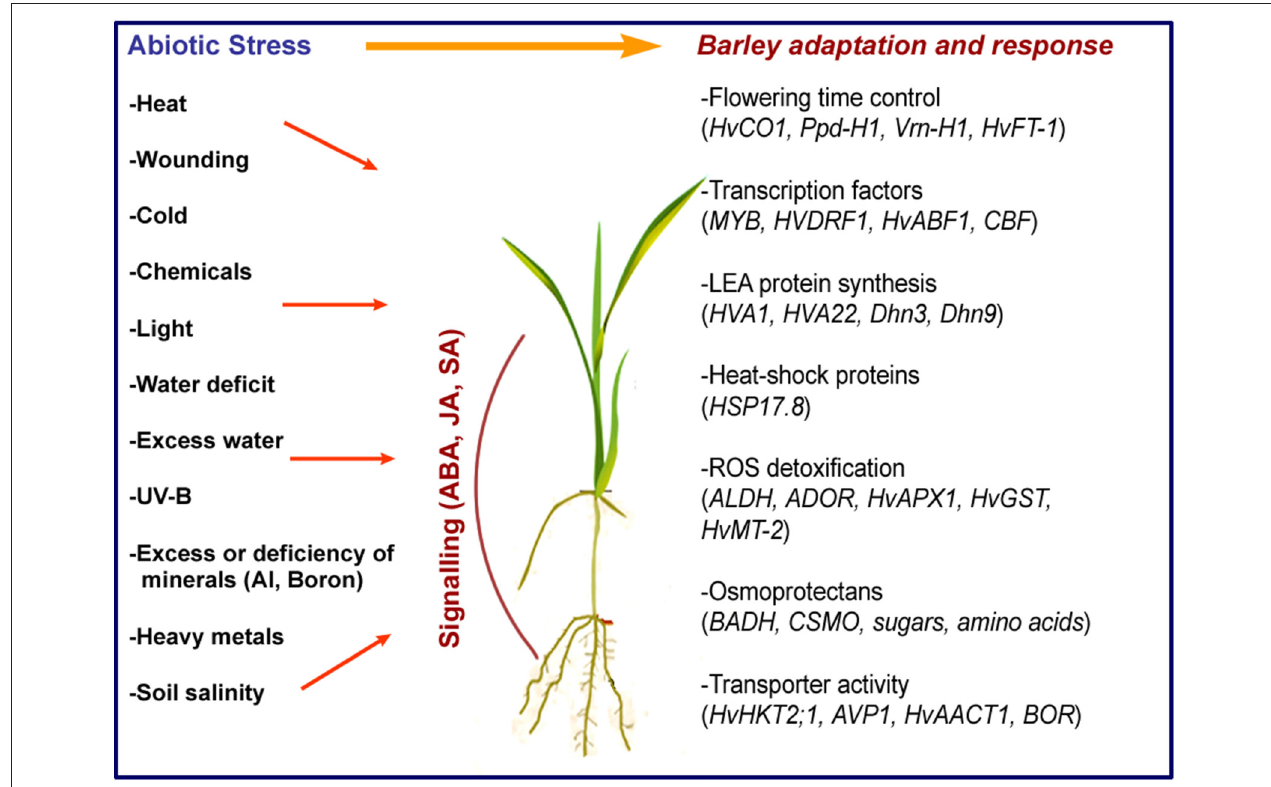
FIGURE 1 | Abiotic stress factors and main genes involved in adaptation and response in barley.